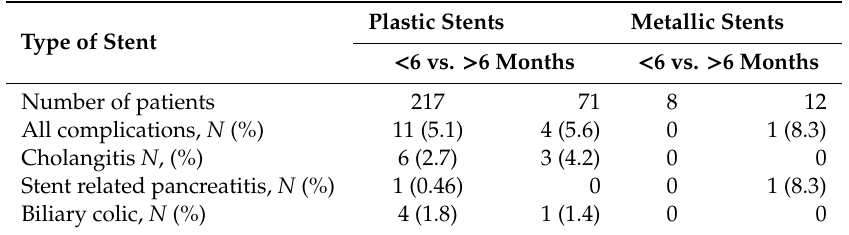
Table 4. Complications rate according to biliary stent type.